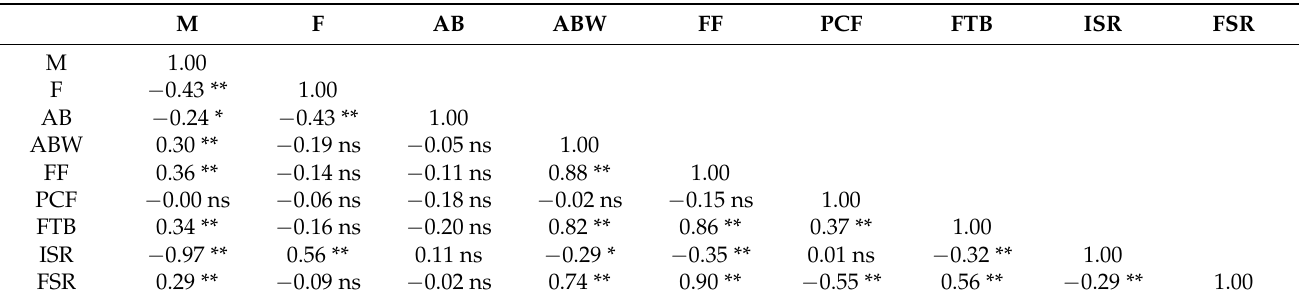
Table 5. Correlation coefficients among traits of biparental